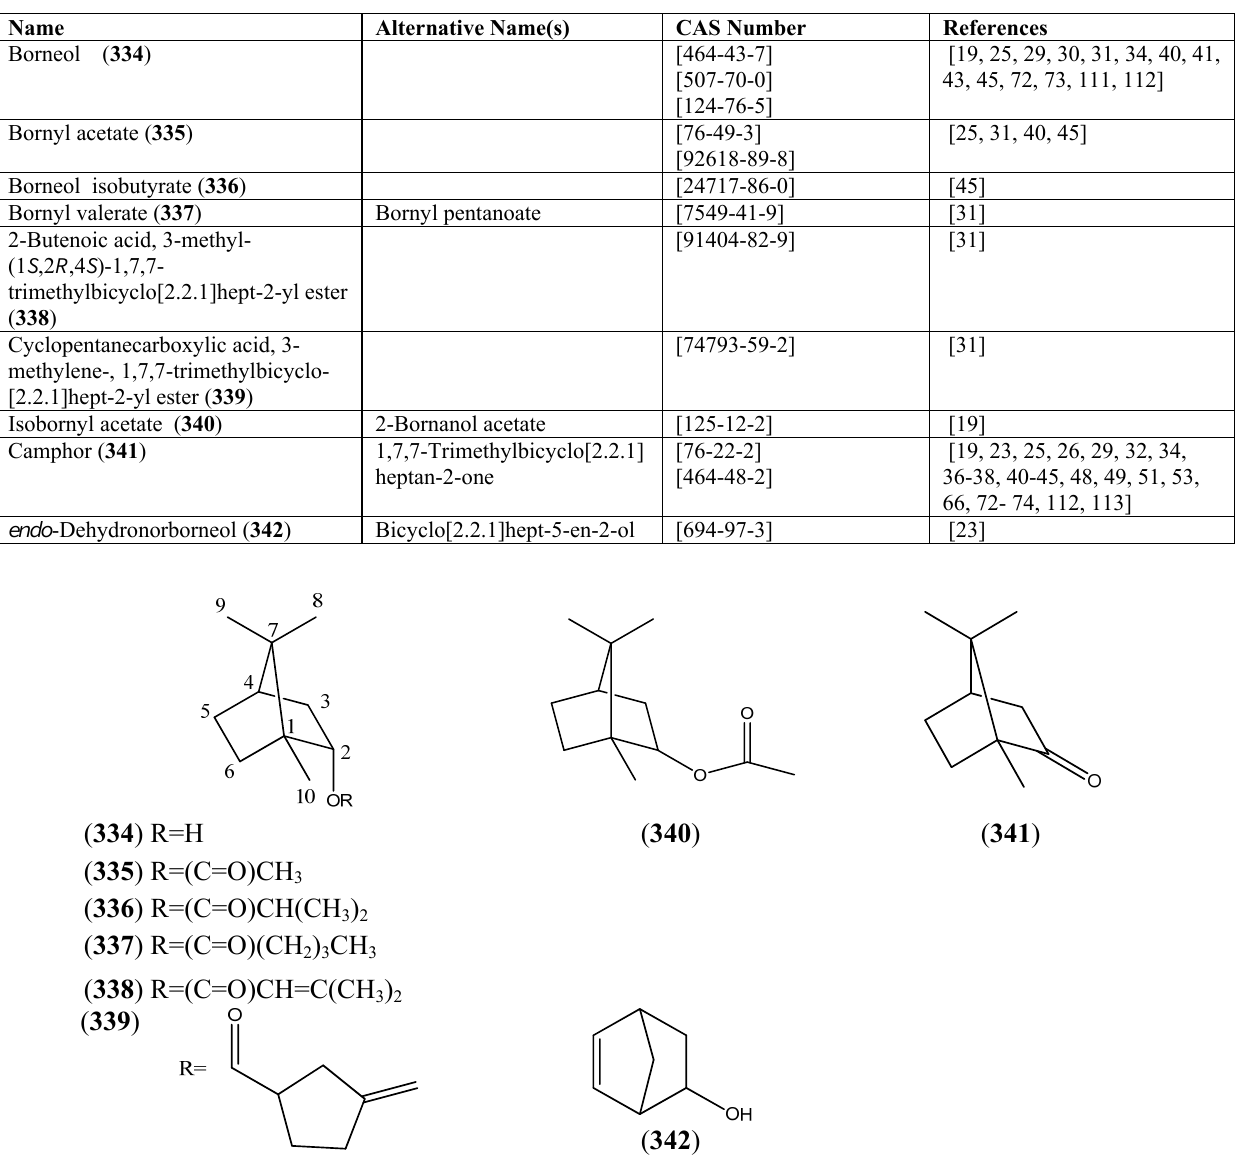
Table 26. Camphane Monoterpenoids (1,7,7-Trimethylbicyclo-[2.2.1]heptane,